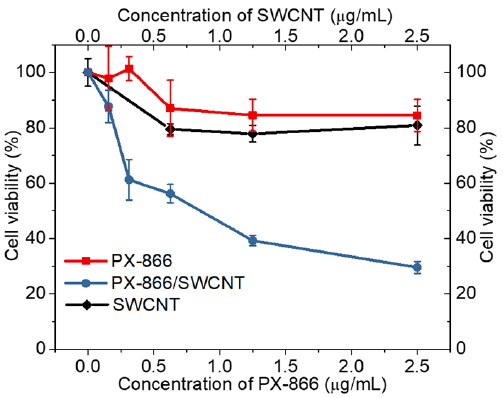
Figure 6. MTT assay cell viability of HepG2 cells treated with either SWCNTs, PX-866, or SWCNT/PX866 conjugates.